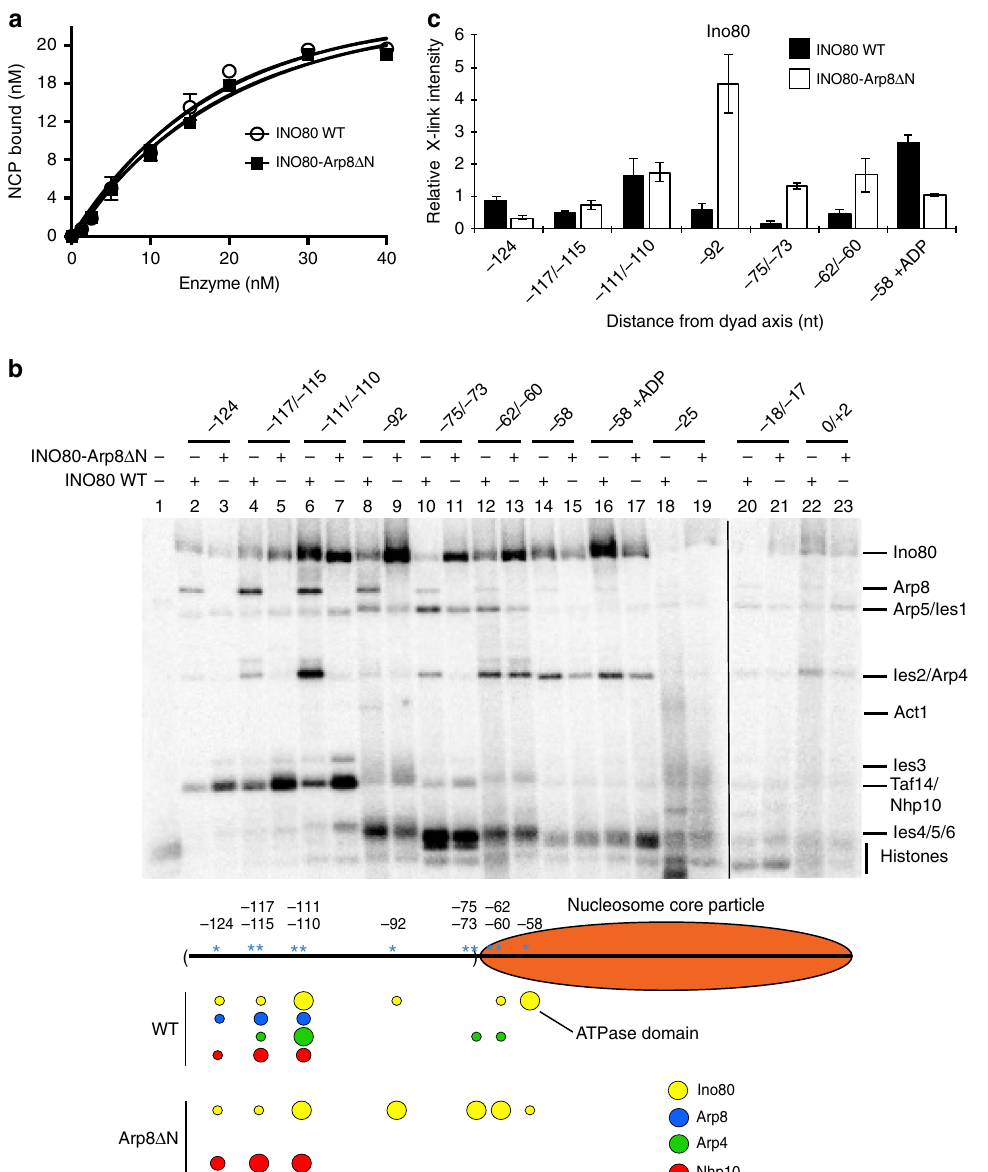
Fig. 3 Binding of Arp8 and Arp4 to extranucleosomal DNA mediates the proper docking of the Ino80 catalytic subunit onto nucleosomes. a Plots showing the fractions of end-positioned (70N0) nucleosomes bound by wild type and Arp8 Δ N INO80 versus increasing concentrations of the enzymes (representative native electrophoretic mobility shift assay (EMSA) images shown in Supplementary Fig. 4a). Error bars denote s.e.m. from three experiments. b Site-speci fi c interactions of wild type and Arp8 Δ N INO80 with nucleosomal and linker DNA were mapped by DNA crosslinking as in Fig. 1a. ADP was added in lanes 16 and 17 (Fig. 1a and ref. 17 ). c Crosslinking ef fi ciencies of the Ino80 catalytic subunit in wild type and Arp8 Δ N INO80 (from b ) at speci fi ed nucleotide positions. The schematic below shows the changes in Ino80, Ap8, Arp4, and Nhp10 crosslinking between wild type and Arp8 Δ N INO80. Circle sizes are proportional to crosslinking ef fi ciencies at the speci fi ed DNA positions. Values are mean of three experiments, normalized to the Ino80 subunit of wild type at nt − 58 without ADP (lane 14 in panel b ). Error bars denote ± mobilize nucleosomes and the observed nucleosome spacing activity of INO80 32 . It appears unlikely that Arp8 promotes nucleosome movement by pushing DNA into nucleosomes as DNA gaps and nicks between where the Arp8 module bind and the entry site of nucleosomes do not interfere with INO80- mediated nucleosome movement 17 .